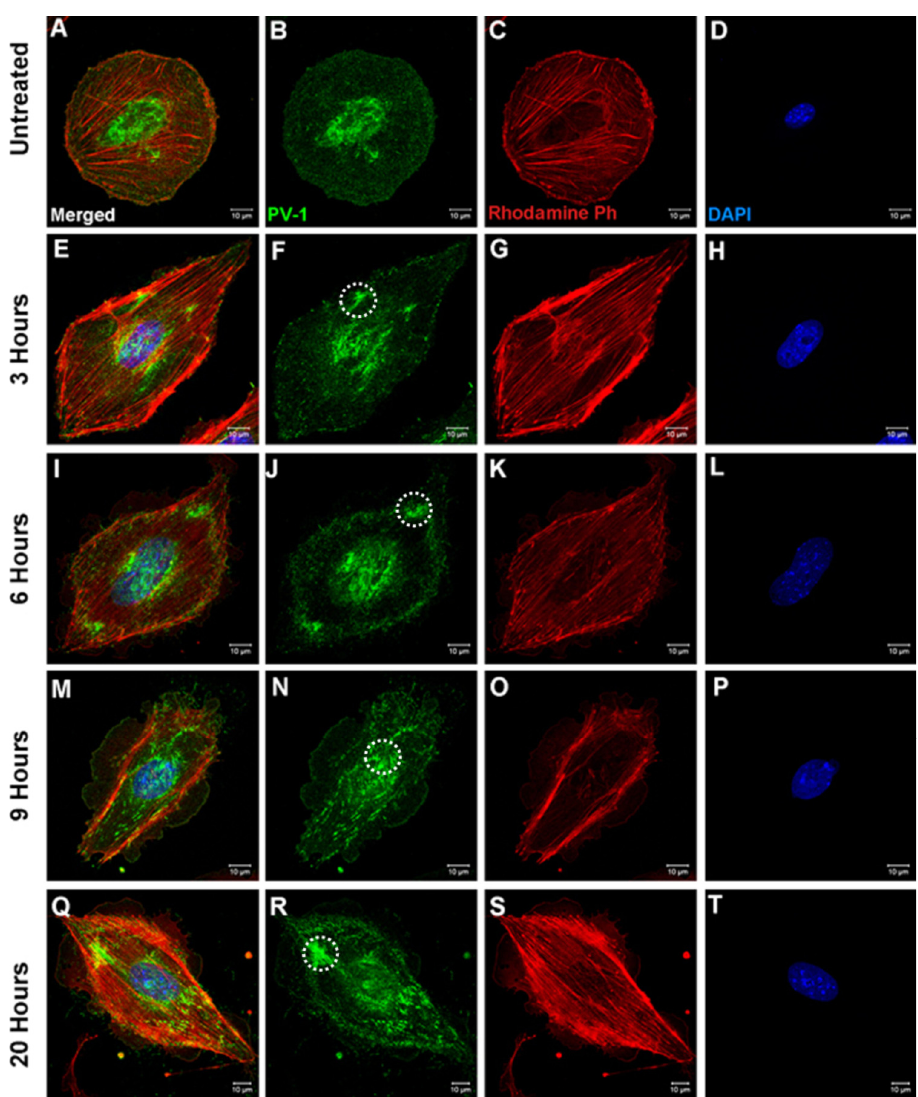
Figure 3. Time-dependent sieve plate formation induced by zinc. When compared to control ( B ) 125 µ M ZnSO 4 induced PV-1 (green) rearrangement as early as 3 h after treatment initiation ( F ); however, sieve plate formation became clearly apparent in cells treated for 9 or more hours ( N , R ). Sieve plate formation is indicated by white dotted circles ( F , J , N , R ). There were no significant actin (red) cytoskeletal changes ( C , G , K , O , S ) or degradation of the nucleus (blue) ( D , H , L , P , T ). ( A , E , I , M , Q ) show the images after merging the different fluorescence